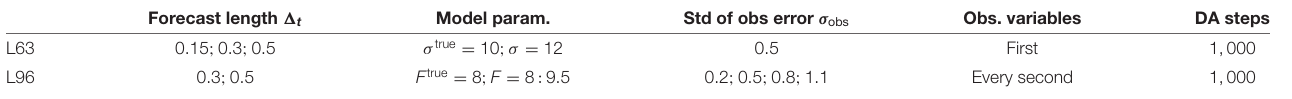
TABLE 1 | Parameters of the model configuration and experimental setup for the Lorenz 1963 (L63) and 1996 (L96) models. Forecast length 1 t Model param. Std of obs error σ obs Obs.